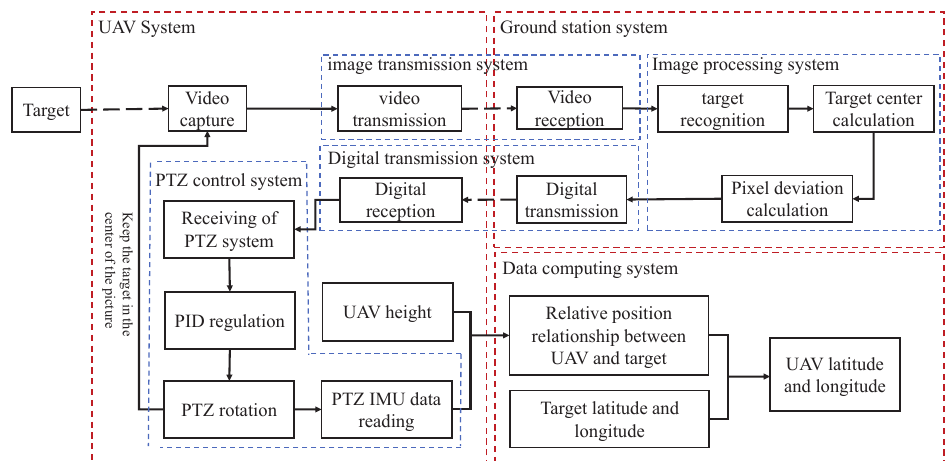
Figure 6. The architecture of the PBVS system for the multi-rotor